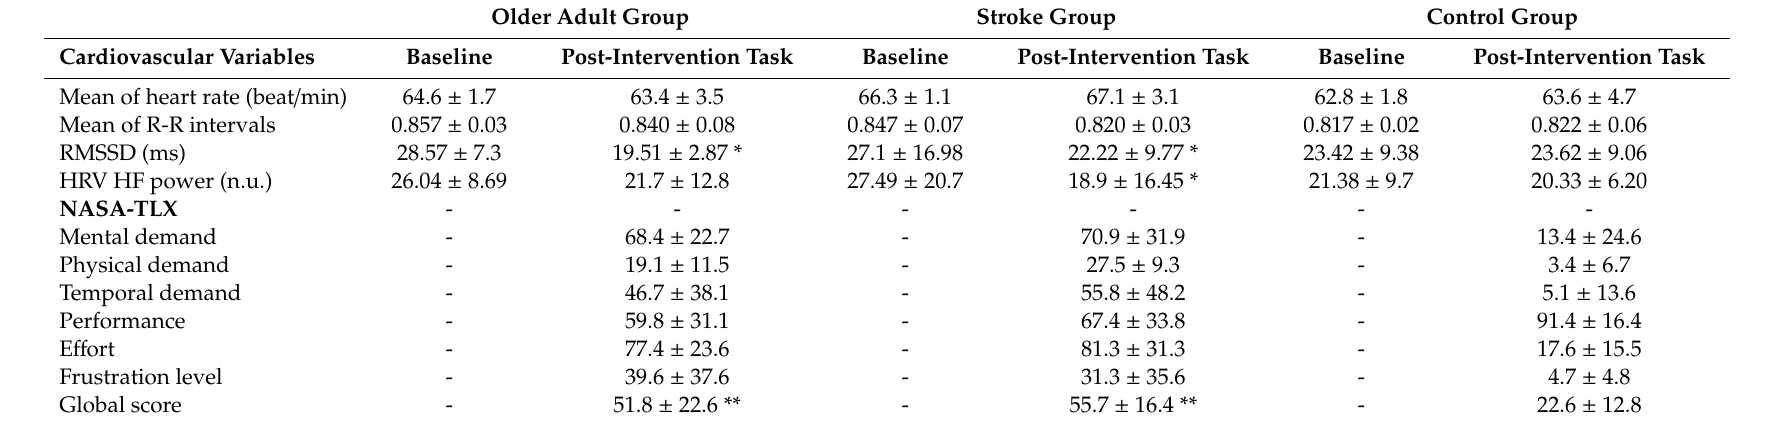
Table 2. Psychophysiological workload